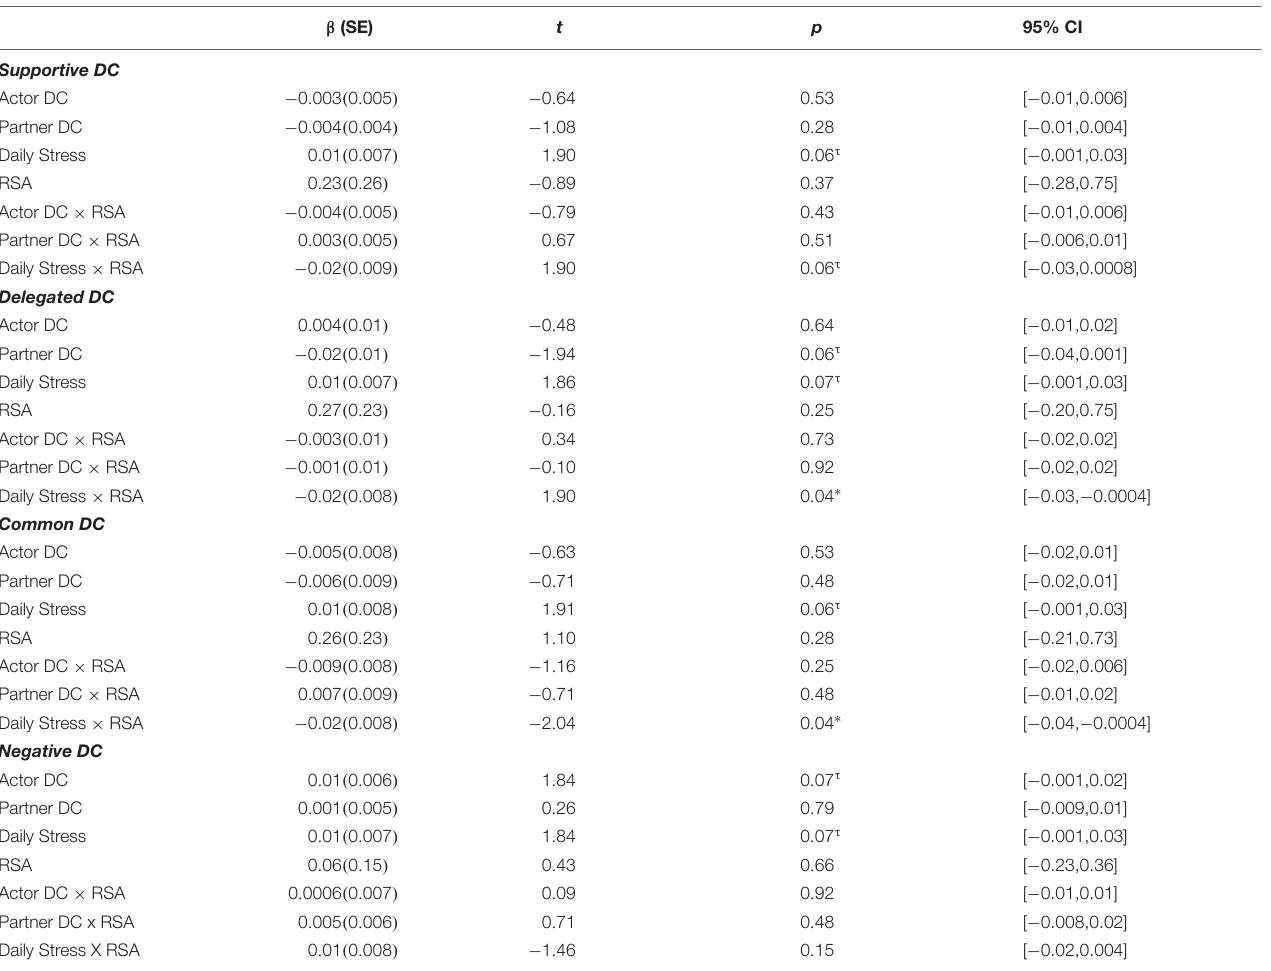
TABLE 3 | Actor and partner effects of DC on depression and moderation effects of RSA for women. β